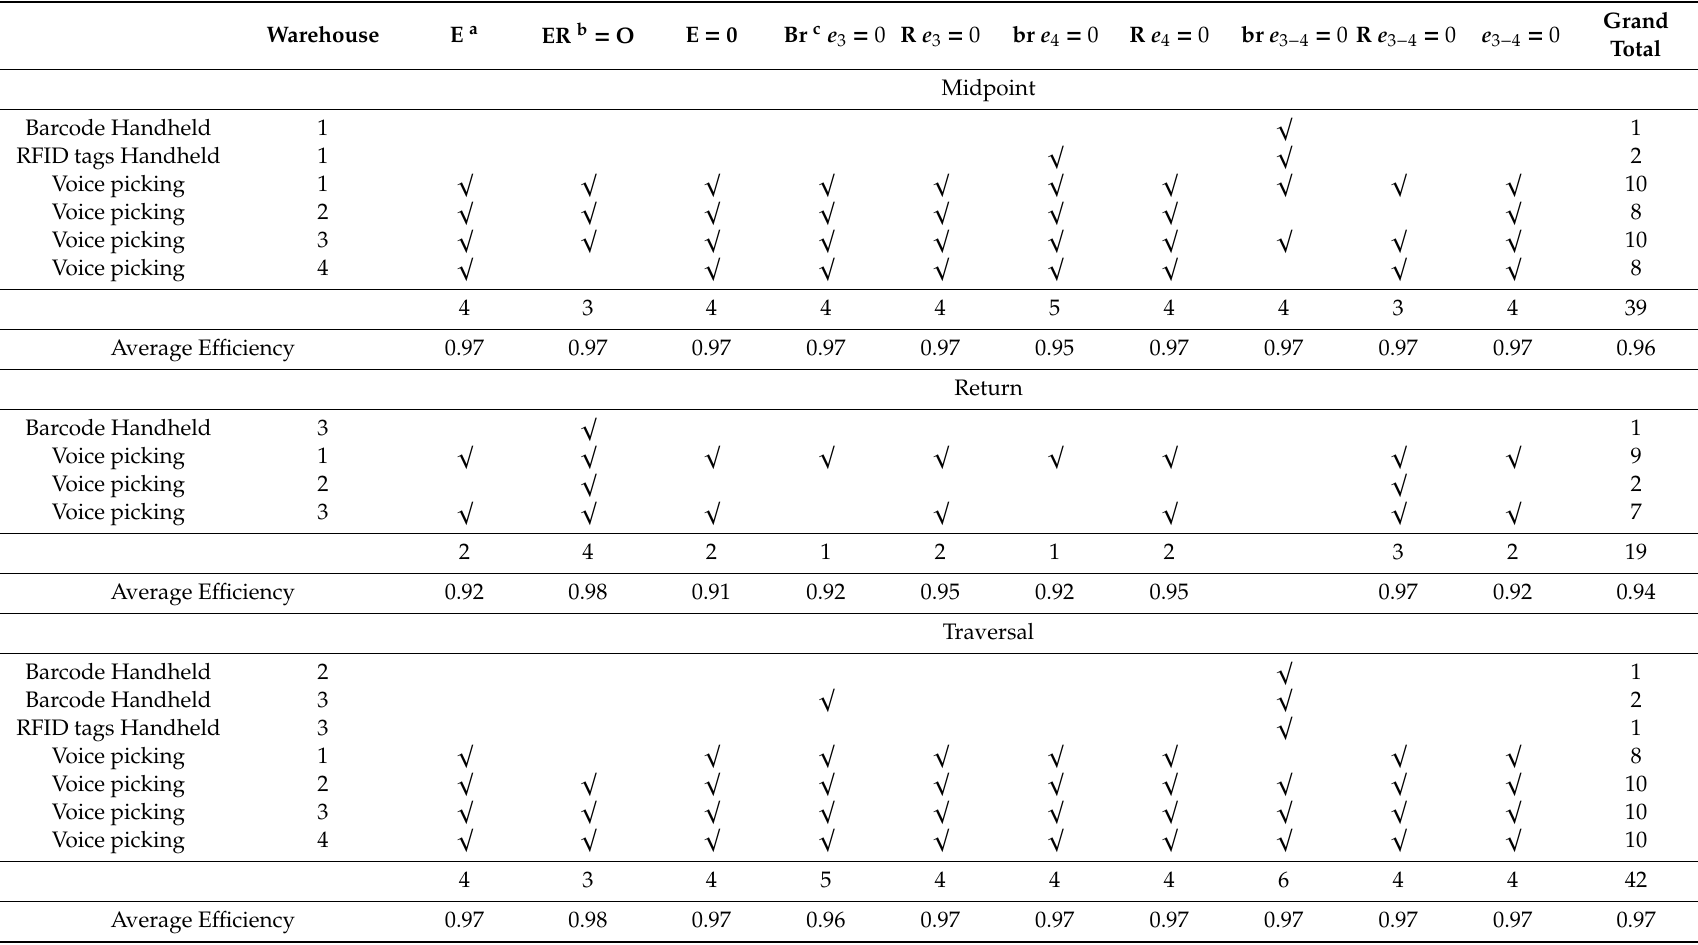
Table 6. Distribution of the 10 best performing